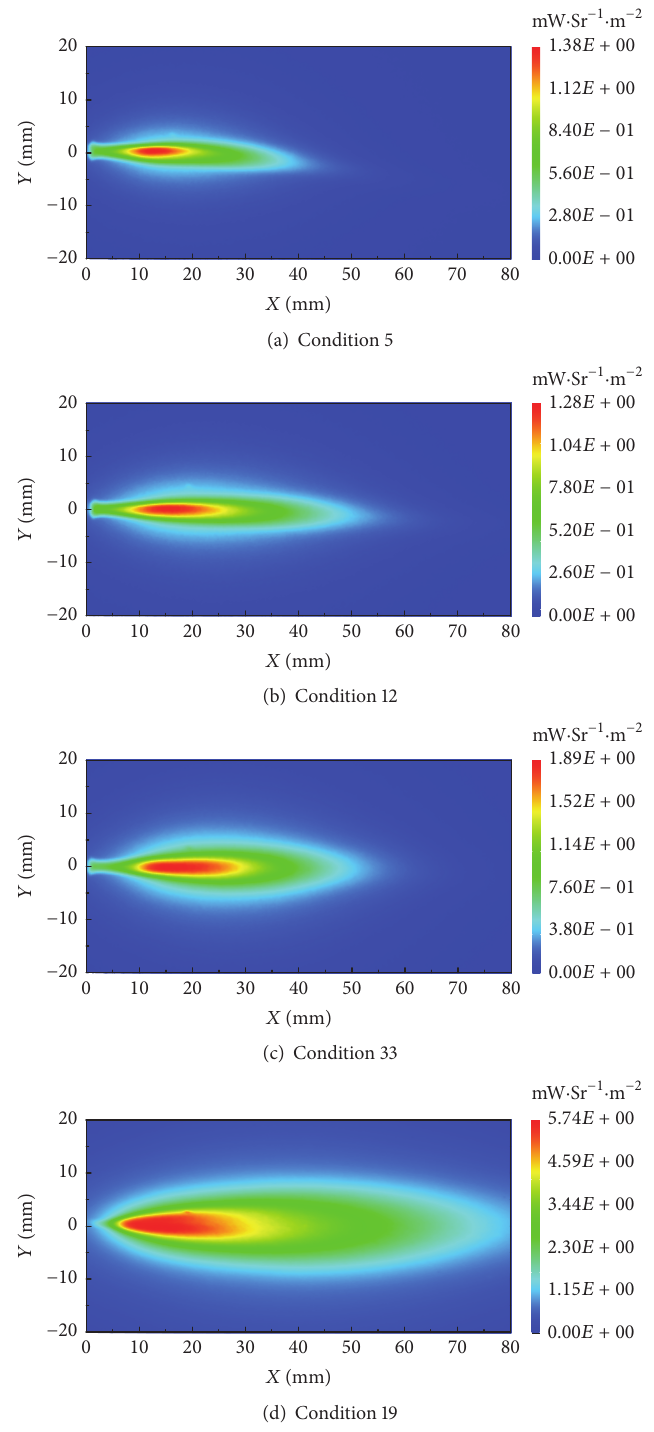
Figure 5: OH ∗ distribution and emission intensity in ethanol